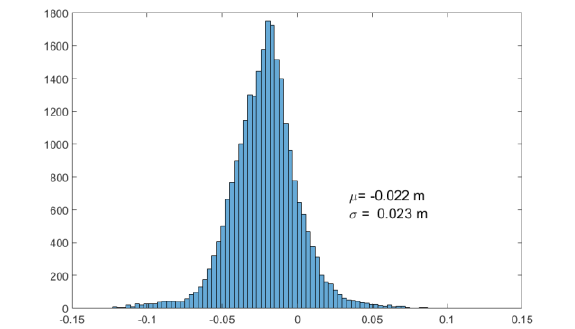
Figure 7. Difference between PSI and DInSAR results calculated for the date of 13.03.2019